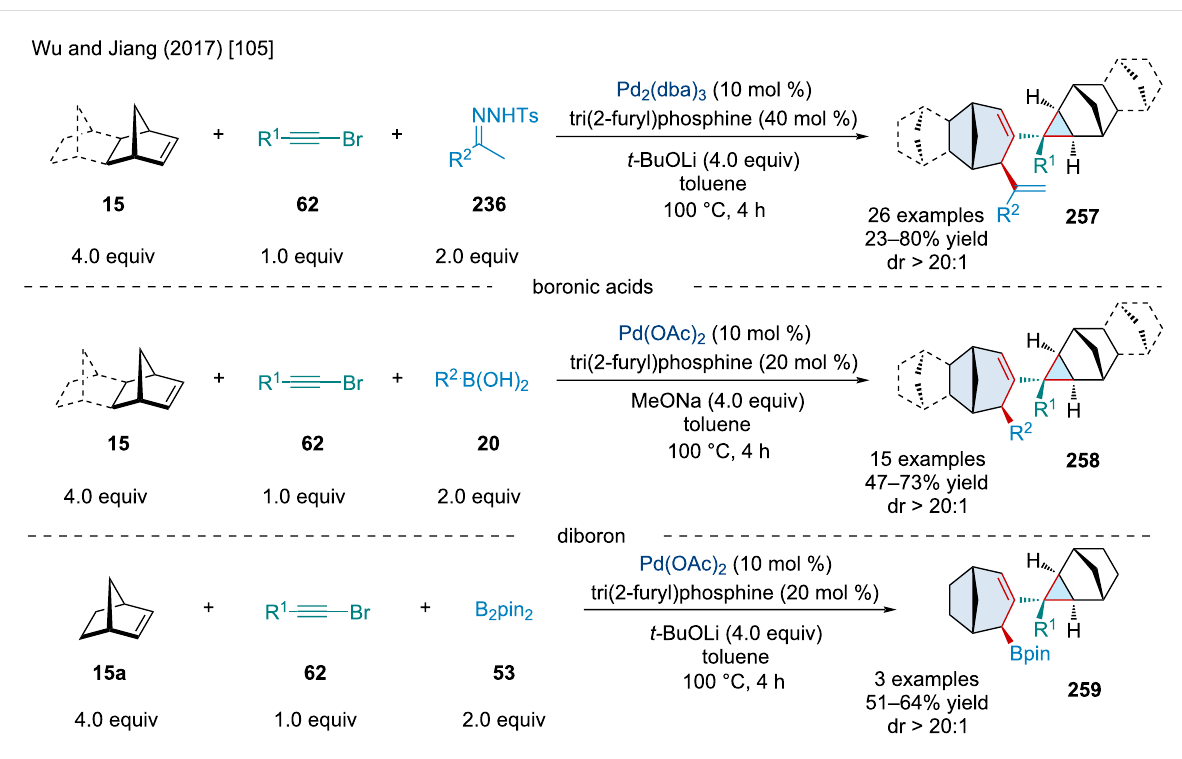
Scheme 49: Pd-catalyzed, three-component coupling of alkynyl bromides 62 and norbornene derivatives 15 with electrophilic trapping